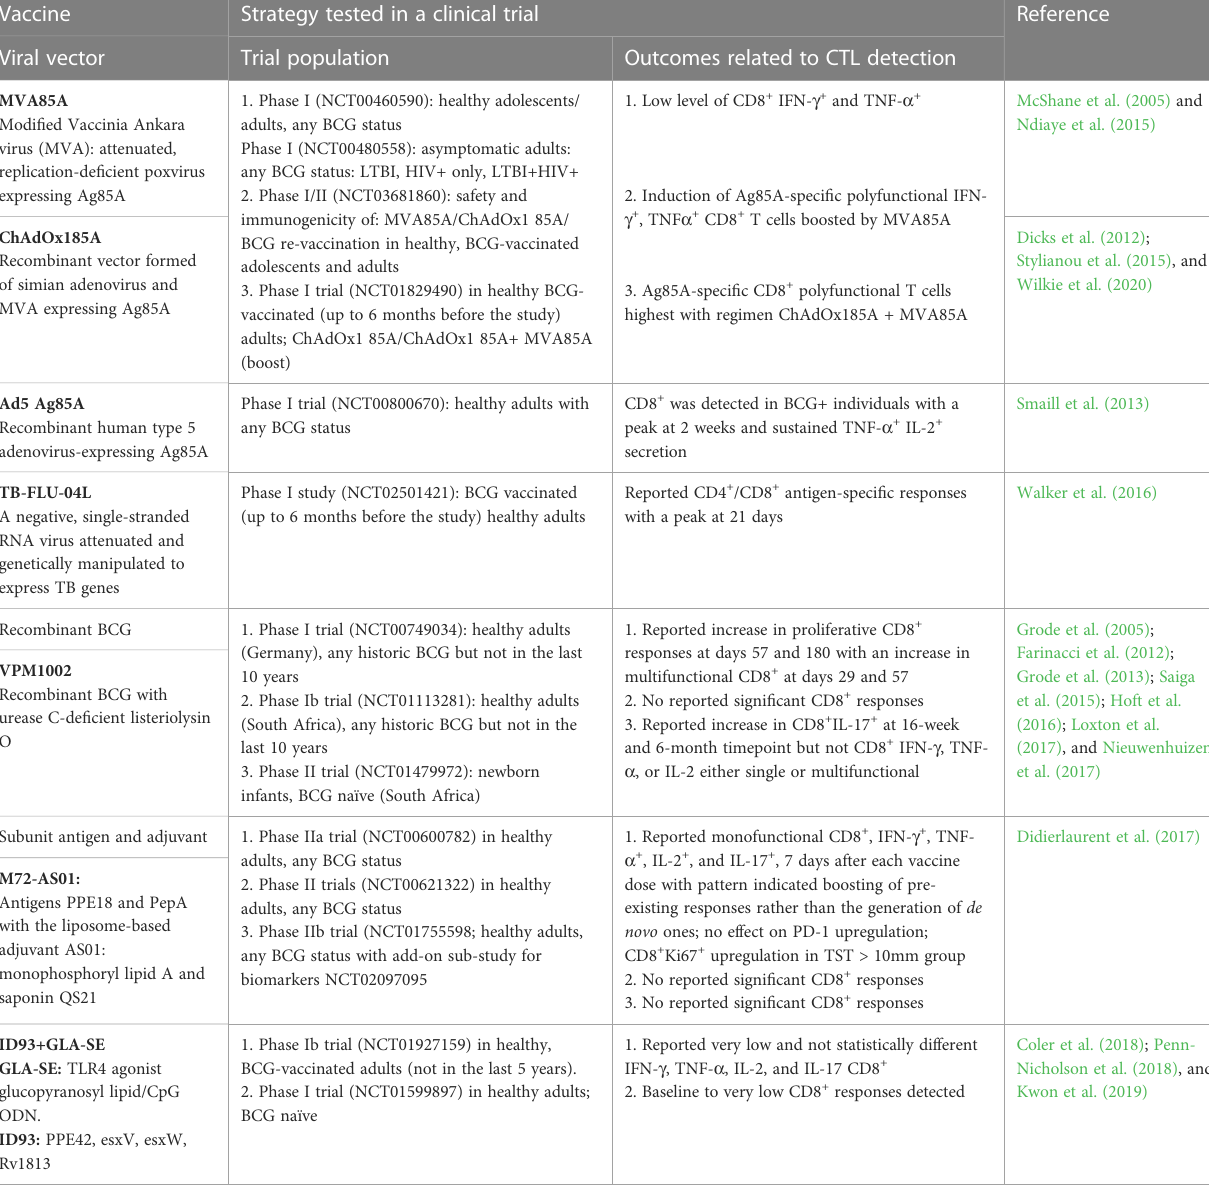
TABLE 2 Summary of selected clinical trials for new vaccines against TB that include outcomes related to the cytotoxic T cell. Vaccine Strategy tested in a clinical